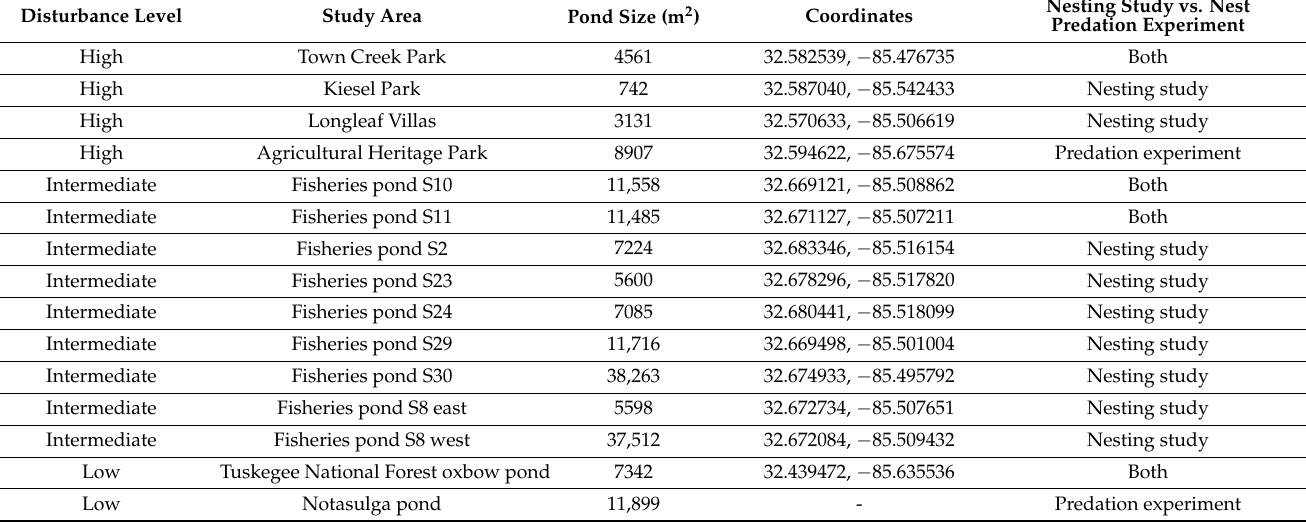
Table 1. Study areas where turtle nesting was observed and where the nest predation experiments were performed. The coordinates for the pond on private property were omitted to maintain landowner